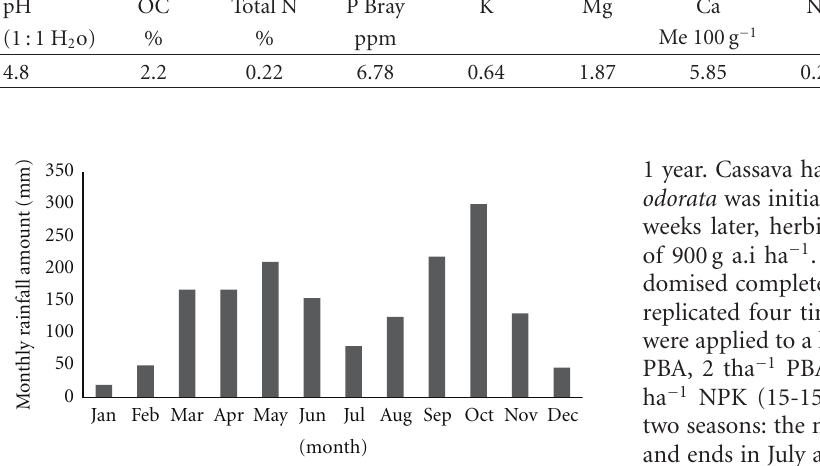
Figure 1: Monthly rainfall distribution at the study site during the experimental